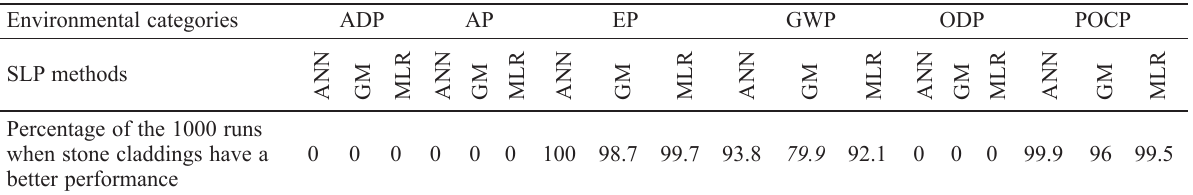
table 9. Monte-Carlo analysis of the lCA results (for each environmental category) for cumulative stages “A1–A3, B4, C3–C4, and D” using stochastic SlP environmental categories